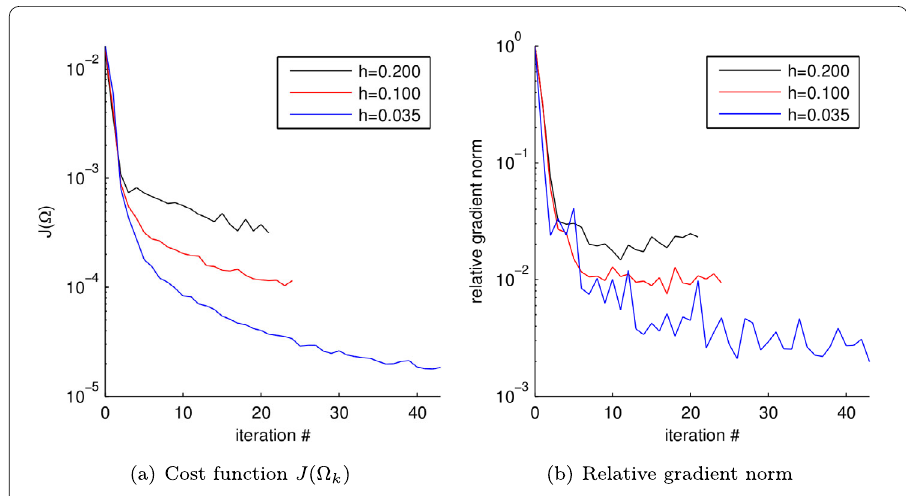
Figure 5 Convergence of the cost functional and the relative gradient norm using Algorithm 1 to compute Cavity A with different mesh sizes